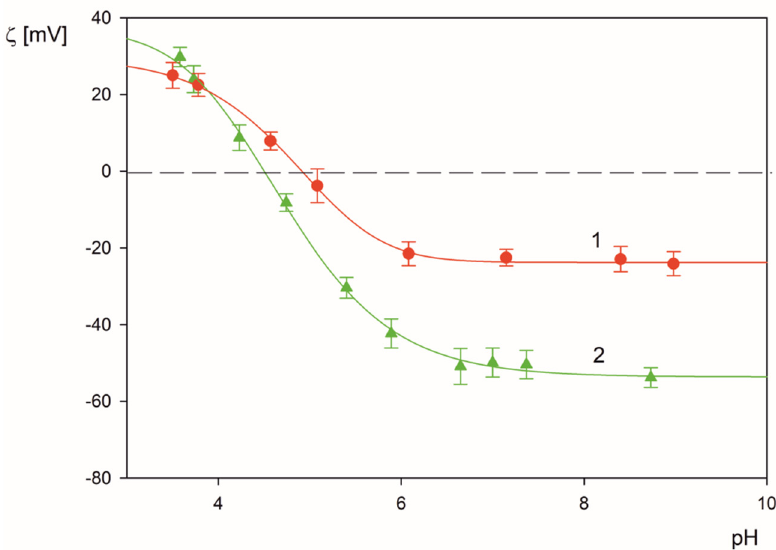
Figure 3. The dependence of the zeta potential of the LSFi particles on pH (fibrinogen corona of the coverage equal to 2.2 mg m − 2 was formed at pH 3.5 and 0.01 mol L − 1 NaCl). The points represent experimental data acquired using the LDV method for ( ● ) 0.01 mol L − 1 NaCl, ( ▲ ) 0.001 mol L − 1 NaCl. The solid lines 1, 2 are fits of experimental data.